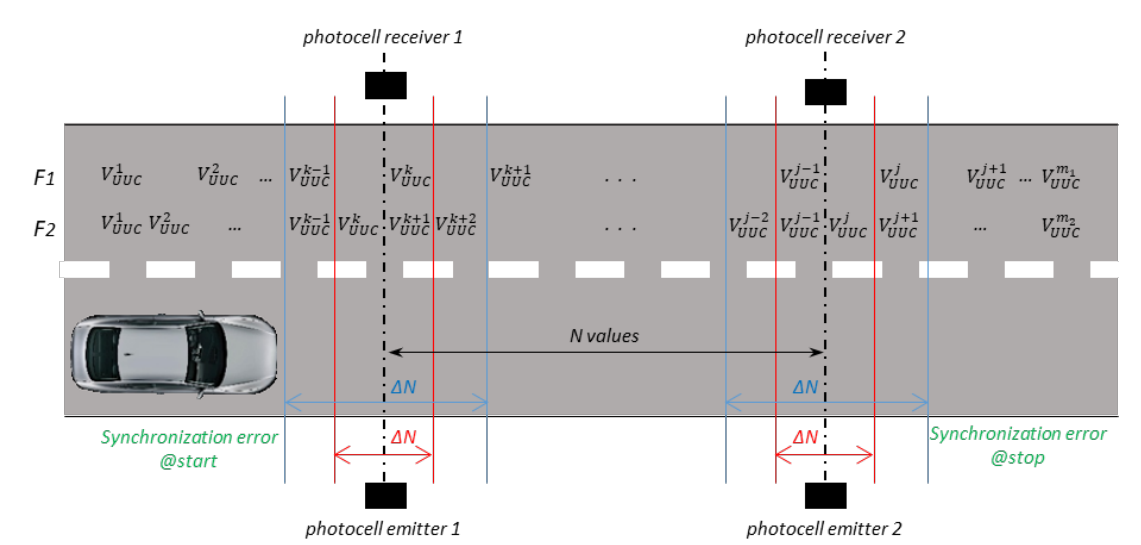
Figure 7. Schematic of the uncertainty contribution due to the synchronization.